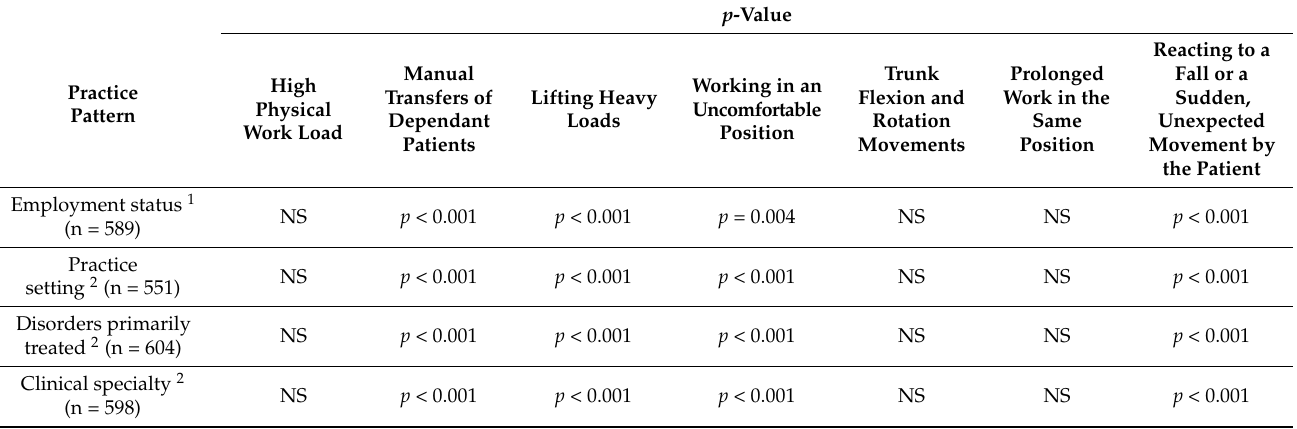
Table 3. Results of statistical tests for exposure to biomechanical risk factors, as a function of practice